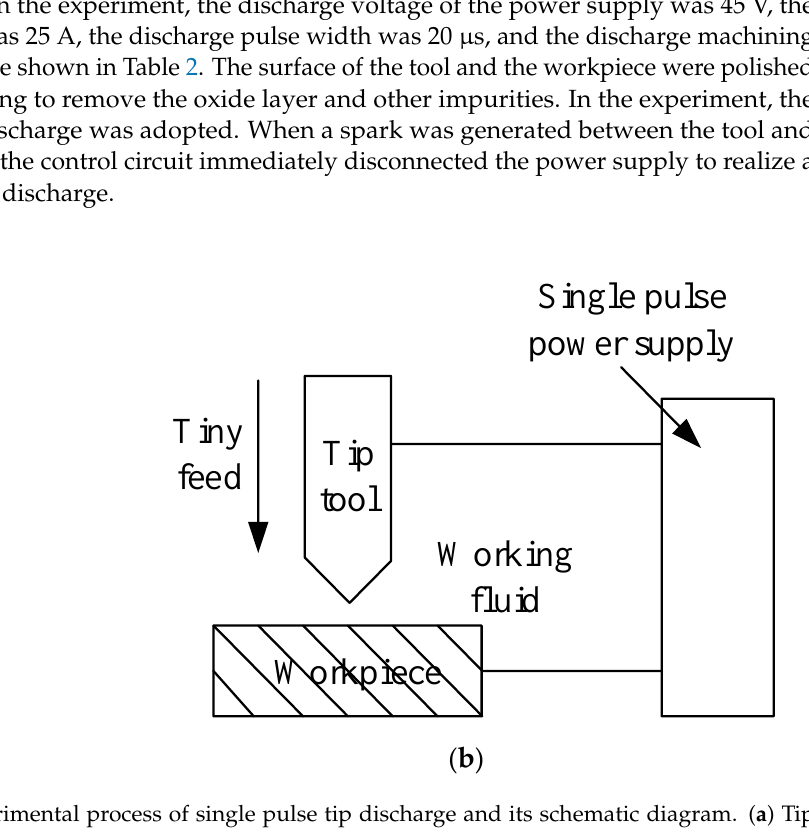
Figure 13. The residual stress after machining.